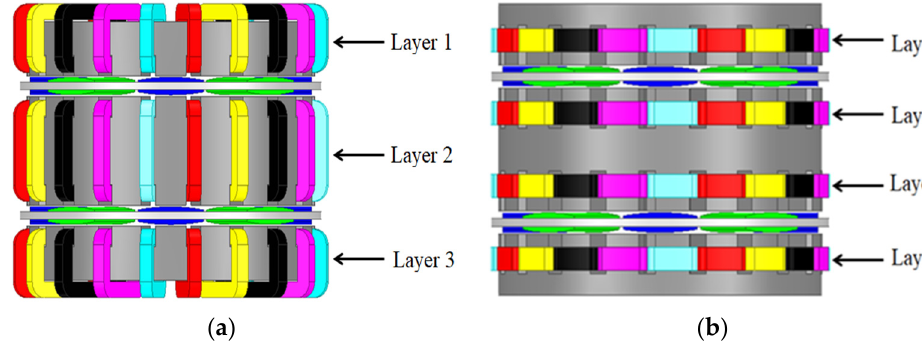
Figure 4. Winding type ( a ) core wound, ( b ) tooth wound .